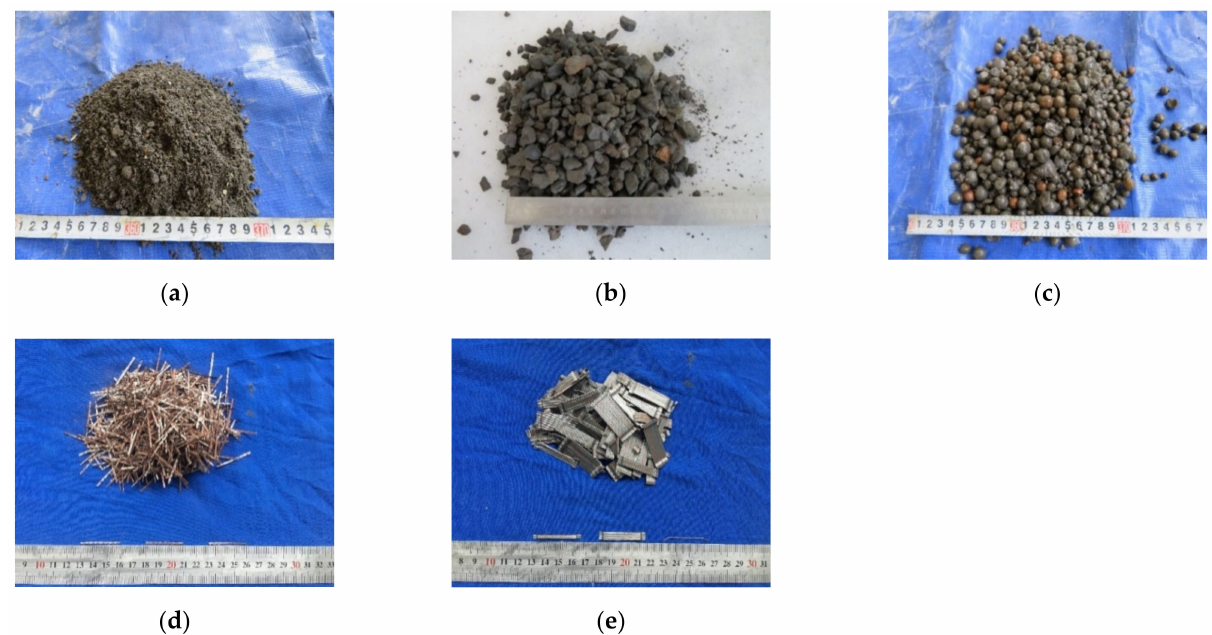
Figure 1. Lightweight aggregates (LWAs) and steel fibers used in the experiment: ( a ) shale ceramsite sand; ( b ) crushed shale ceramsite; ( c ) sintered fly ash ceramsite; ( d ) crimped shape steel fiber; ( e ) hooked end steel fiber.